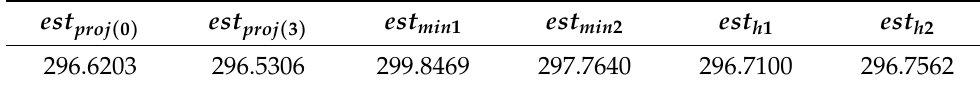
Table 3. Estimating x T A − 3 x = 296.8727, where A = KMS , x = 1 n .